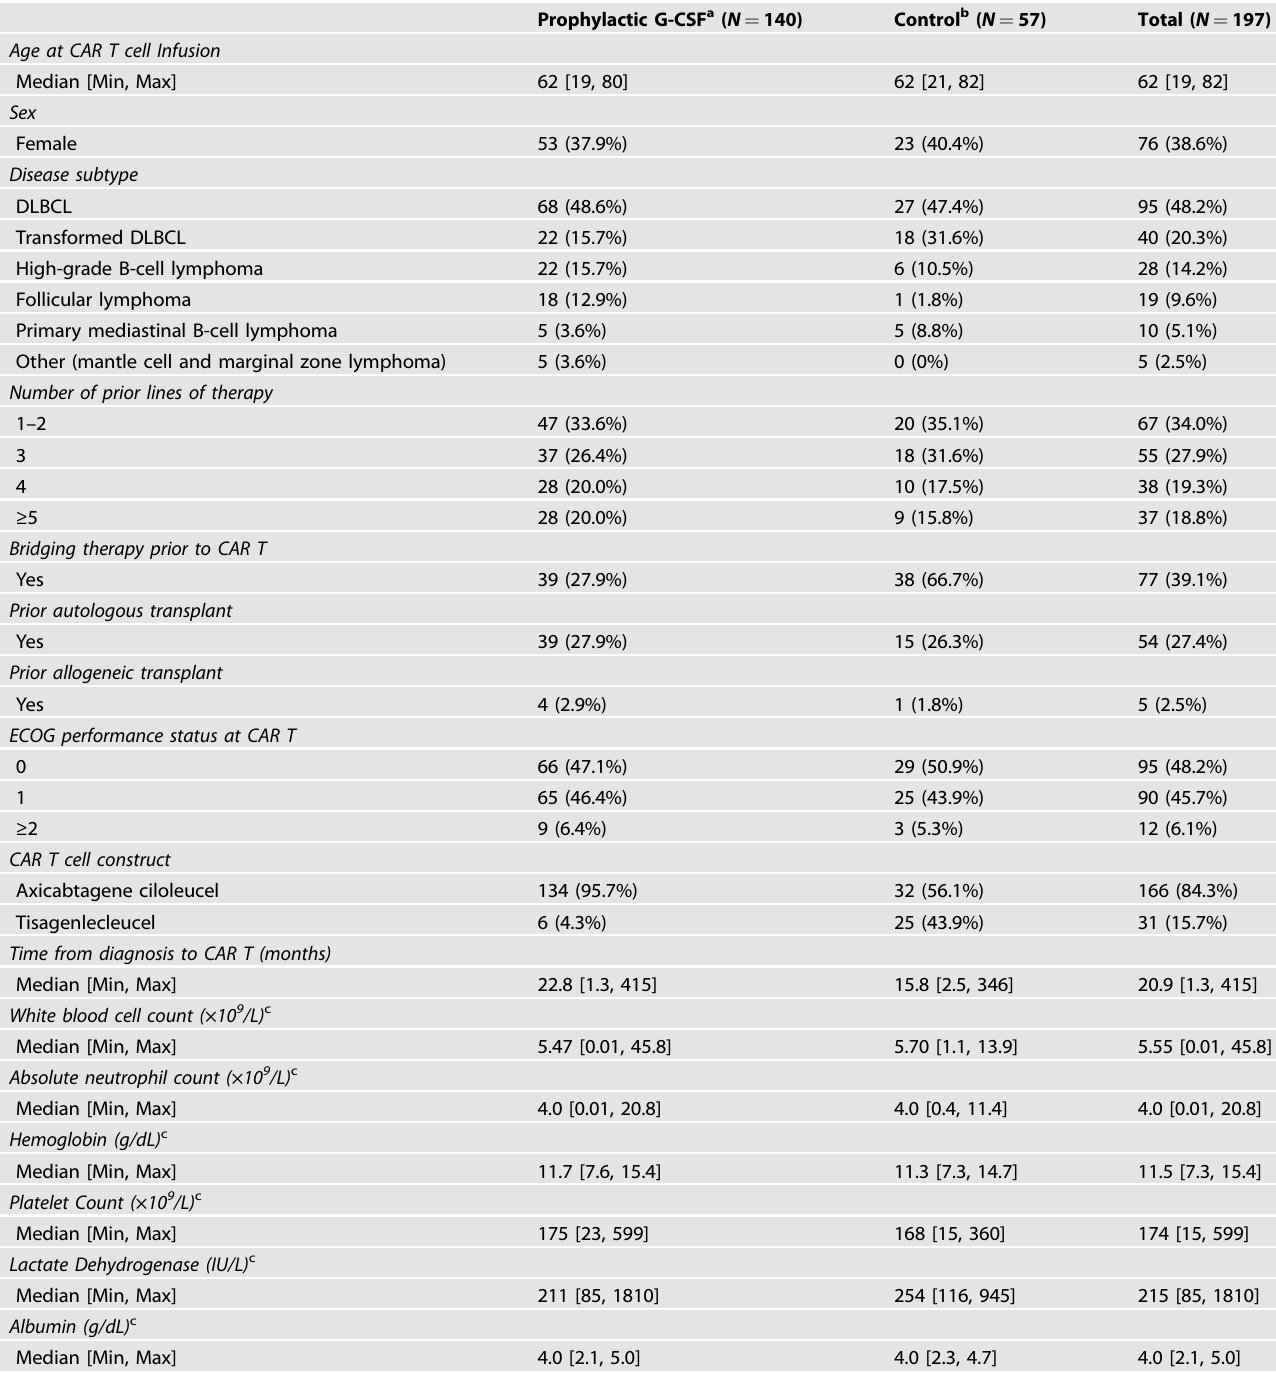
Table 1. Baseline characteristics in lymphoma